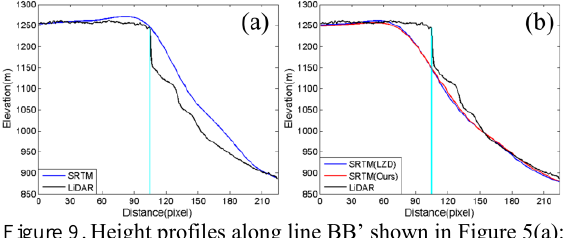
Figure 9. Height profiles along line BB’ shown in Figure 5(a): (a) before coregistration, (b) after coregistration (LZD and our